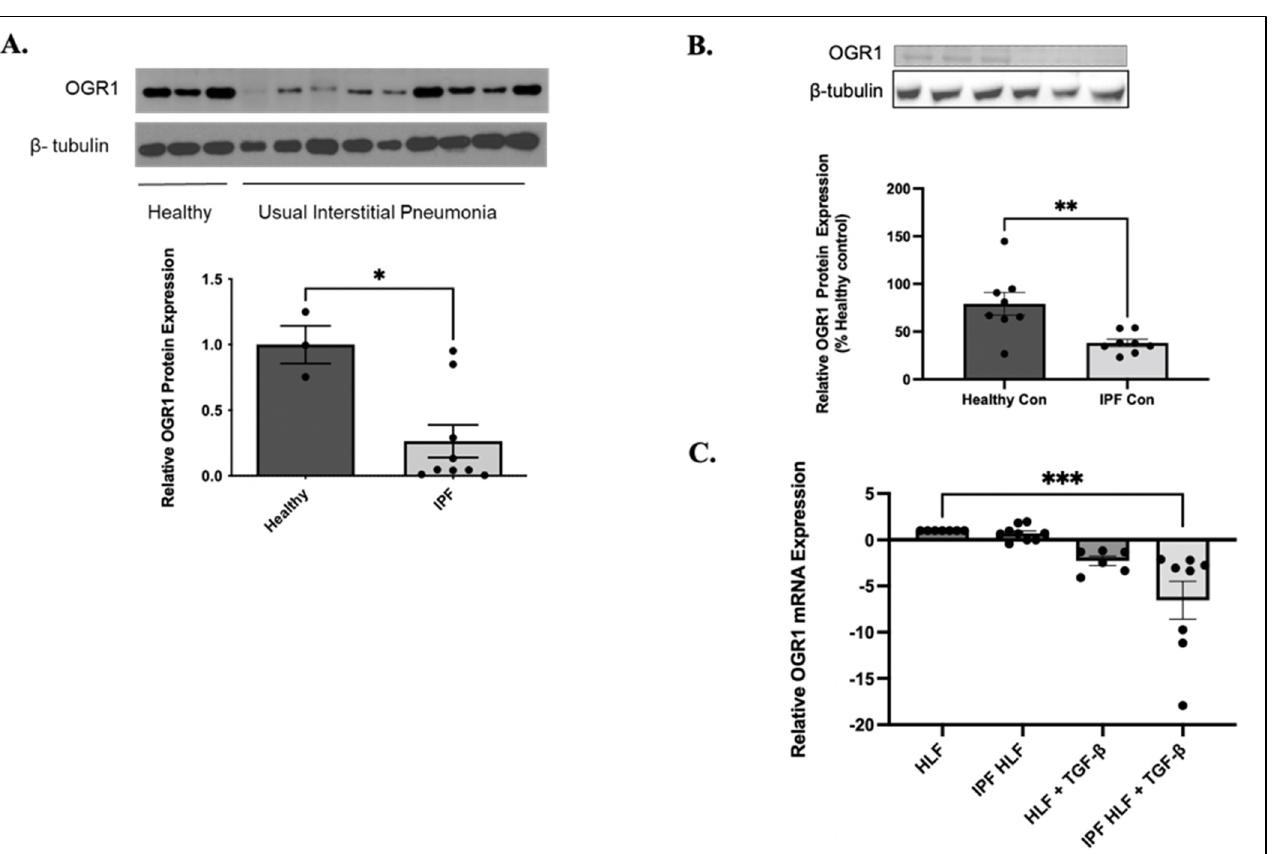
Figure 1 . OGR1 protein expression, but not mRNA, are reduced in IPF. Lung tissues from healthy patients and those with IPF were analyzed for OGR1 protein expression by western blot. Densito- metric analysis was performed and data represent mean OGR1 expression relative to β -tubulin ± SEM, * p = 0.0105 ( A ). We next compared OGR1 protein expression between healthy human lung fibroblasts and fibroblasts obtained from patients with IPF. Under basal conditions, IPF-derived fibroblasts demonstrated significantly decreased OGR1 protein expression, ** p = 0.0056 ( B ). We then examined expression of mRNA from healthy and IPF human fibroblasts via qRT-PCR; there was no difference in baseline OGR1 mRNA levels. However, IPF-derived fibroblasts were more sensitive to down-regulation by TGF- β , *** p = 0.0001 ( C ). Data represent mean expression ± SEM.